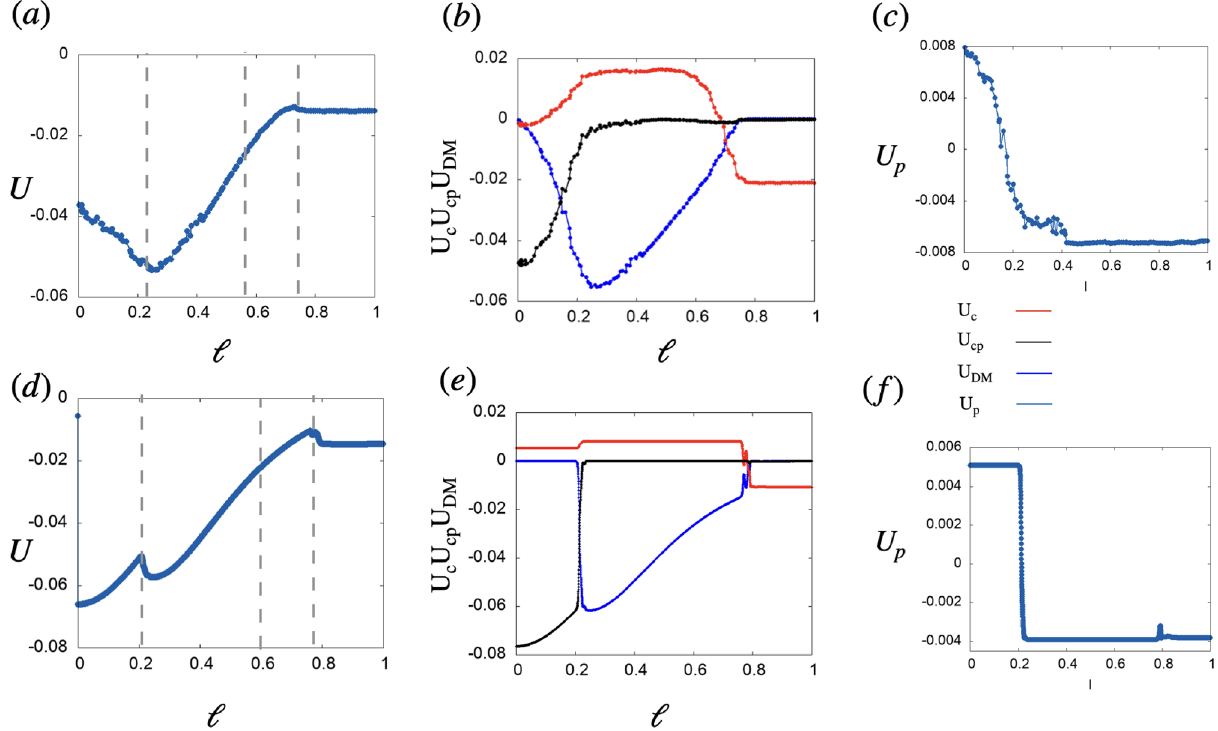
Figure 3. ( a , d ) show the total energy of the system as a function of ℓ in experiments and numerics, respectively. The magnetic phases are delimited by the dotted vertical lines. Using Eq. 1 the contribution of symmetric and antisymmetric long-range interactions to the total magnetic energy is shown in ( b ) (experiments) and ( e ) (numerics) with U c , U cp and U DM shown in red, black and blue respectively. The dark blue curves of ( c ) and ( f ) show U p in experiments and numerics,